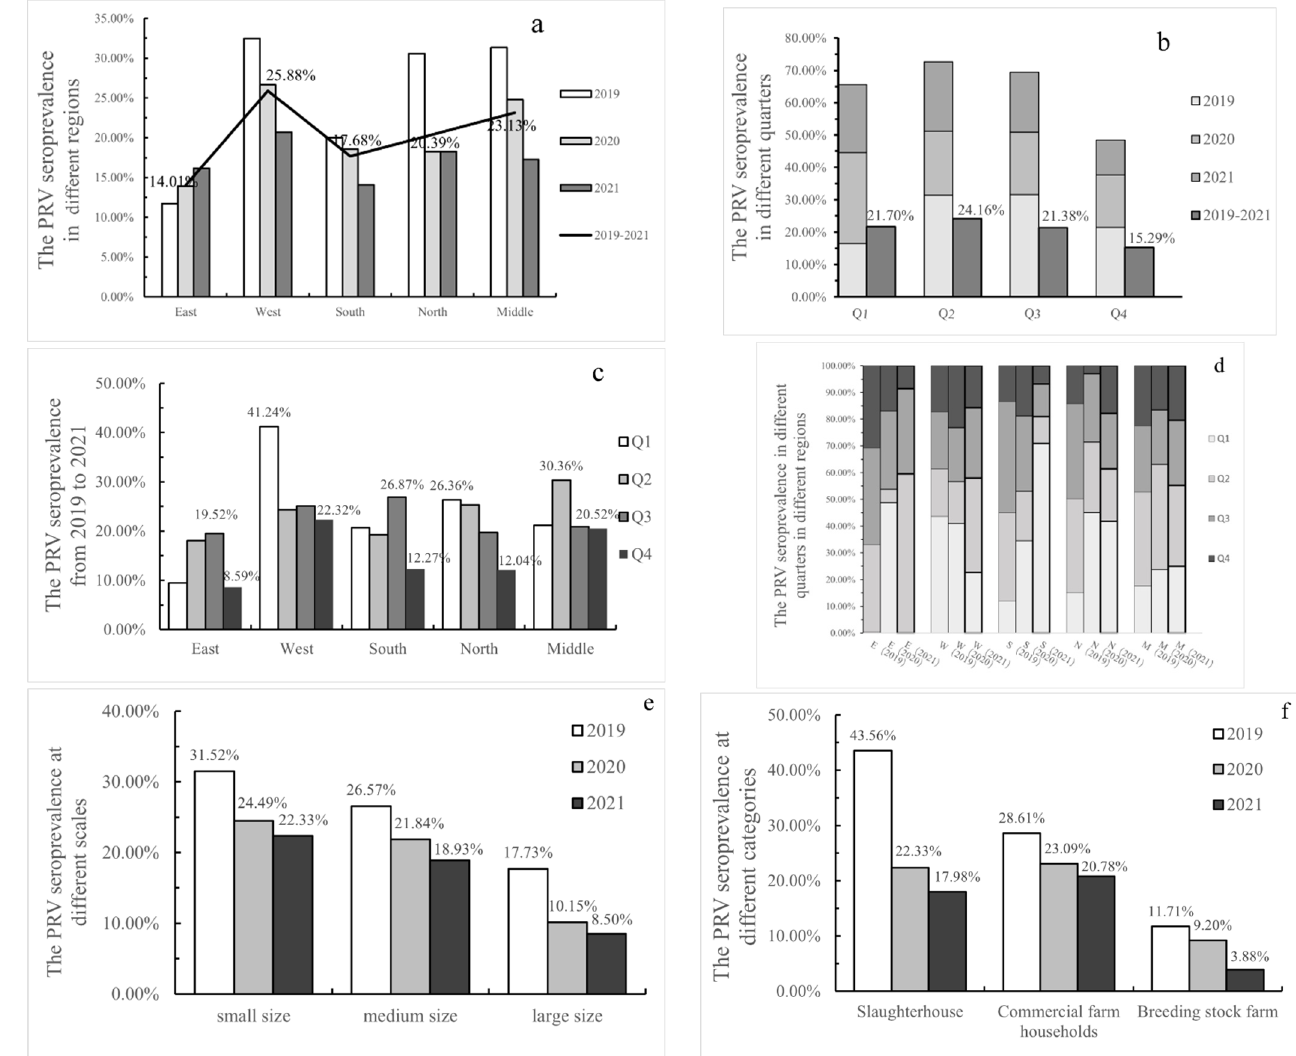
Figure 2. Seroprevalence rate of PRV-gE in the Henan province, China, 2019–2021, from different perspectives. ( a ) Seroprevalence rate of PRV-gE in different regions. ( b ) Seroprevalence rate of PRV-gE in different quarters. ( c , d ) Seroprevalence rate of PRV-gE in different quarters in different regions. ( e ) The PRV-gE seropositive rate of farms of different scales. ( f ) The PRV-gE seropositive rate of farms of different categories.